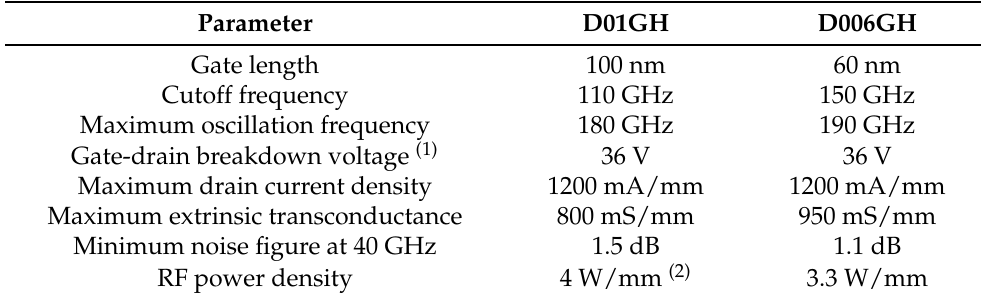
Table 1. Main features of chosen GaN-on-Si